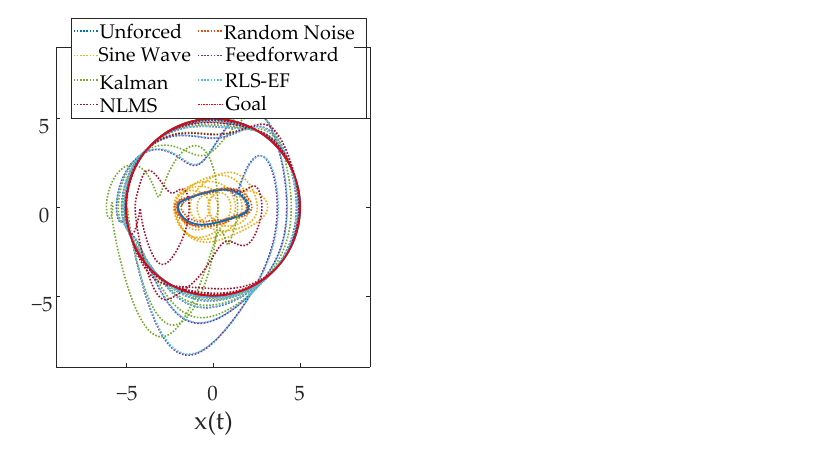
Figure 7. The van der Pol response oscillator trajectory plotted against the target trajectory, a circle of radius 5, for each of the forcing functions. Methods 4 – 7 successfully force the response oscillator to follow the target trajectory. Table 1. Mean absolute error (MAE) for the entire trajectory.